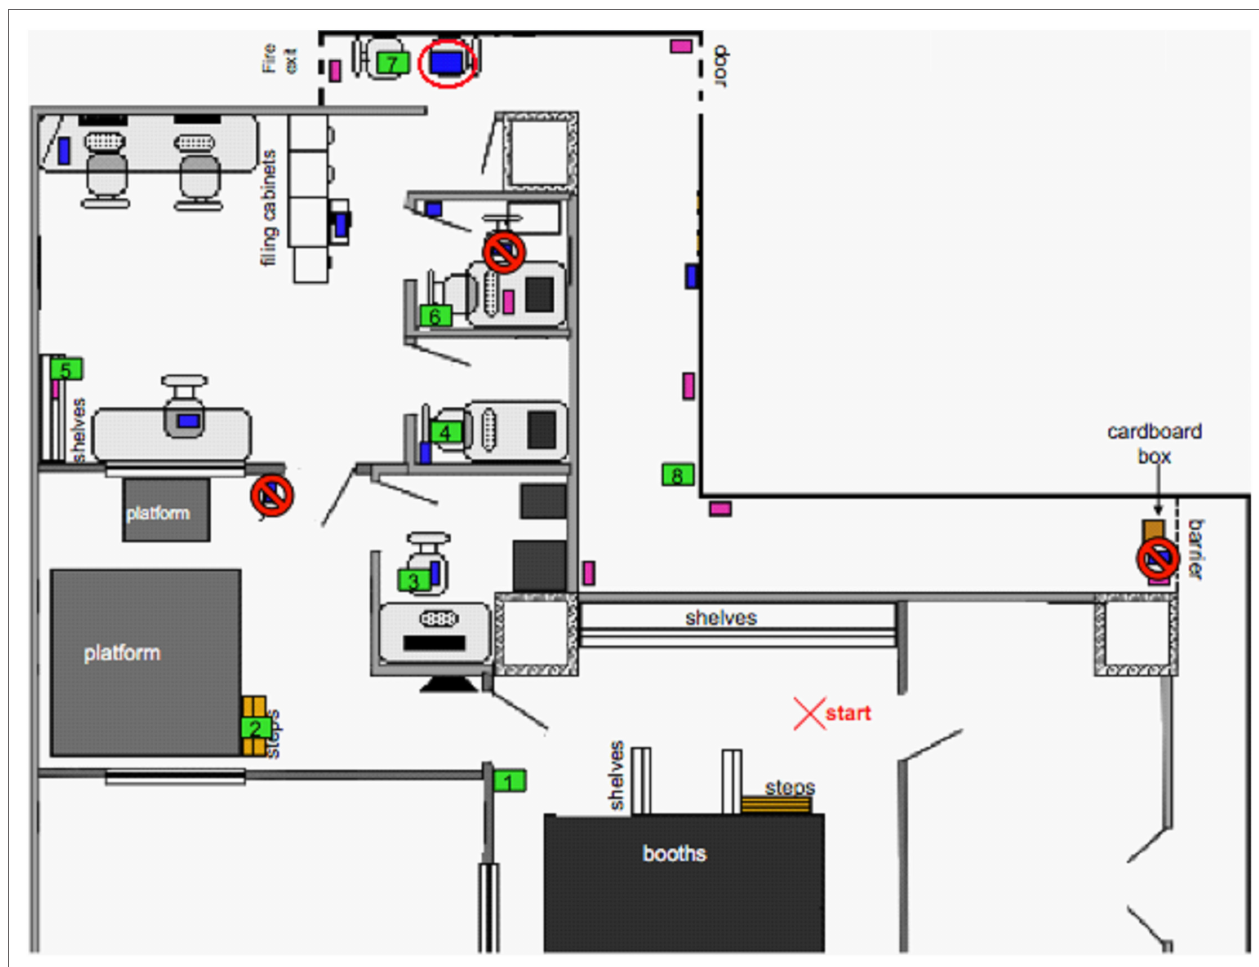
FigUre 1 | Map of search environment showing the locations of the cardboard box, eight green boxes, eight blue boxes, and eight pink boxes, as well as the inaccurate locations of three blue boxes on the director’s map (crossed in red) . One additional blue box (circled in red) was not marked on the director’s map but did exist in the environment. The color labels and locations of the green boxes are included for explanation but were not present for the director.